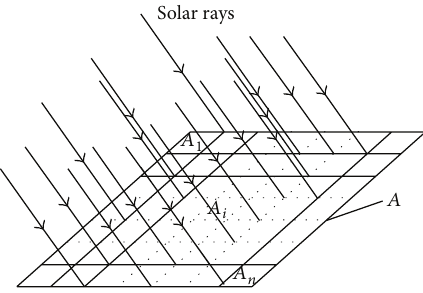
Figure 1: Schematic diagram of solar radiation received by